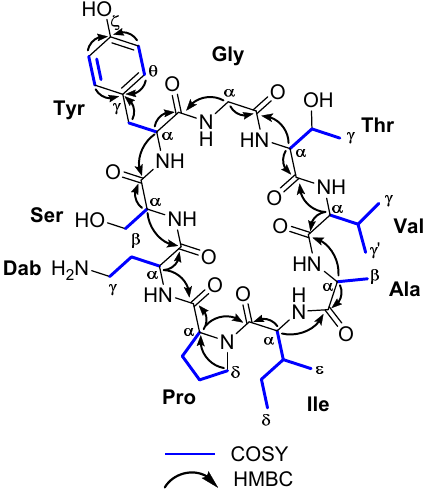
Figure 2. Key COSY and HMBC correlations observed for the cyclononapeptide sclerin ( 1 ).